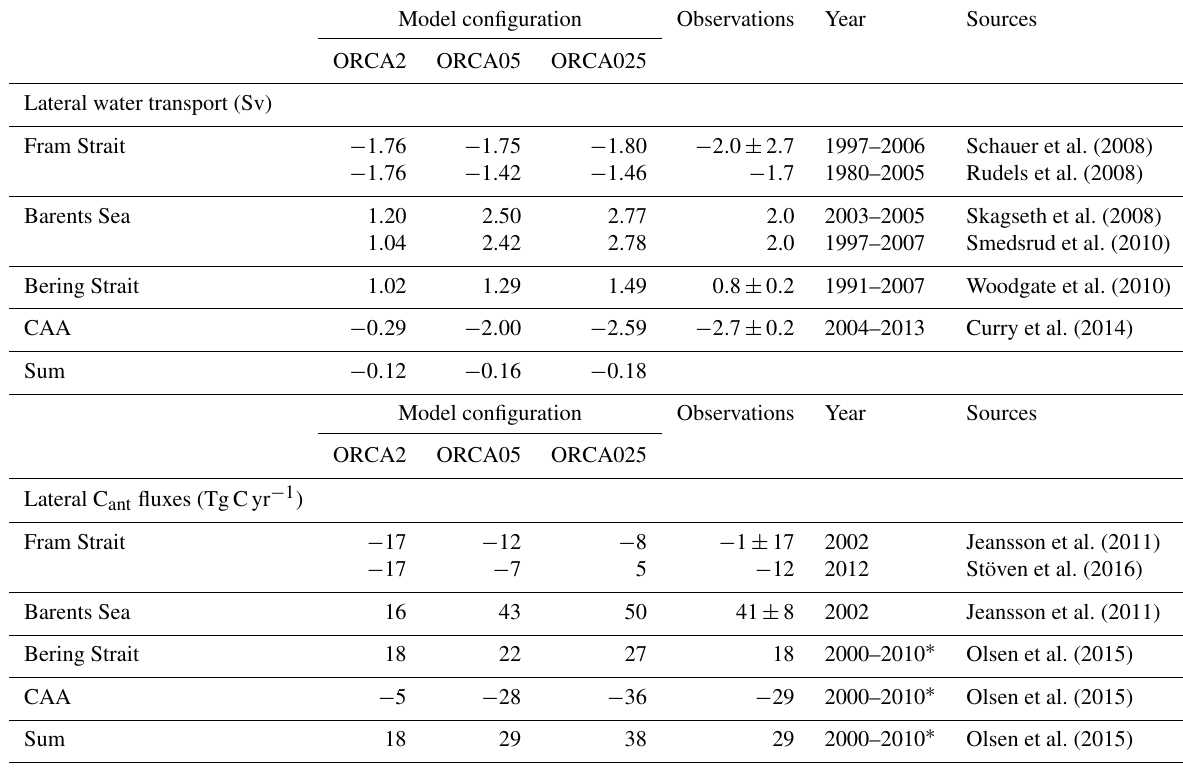
Table 5. Lateral transport of water and C ant across Arctic Ocean boundaries with average simulated values calculated for the same time period as